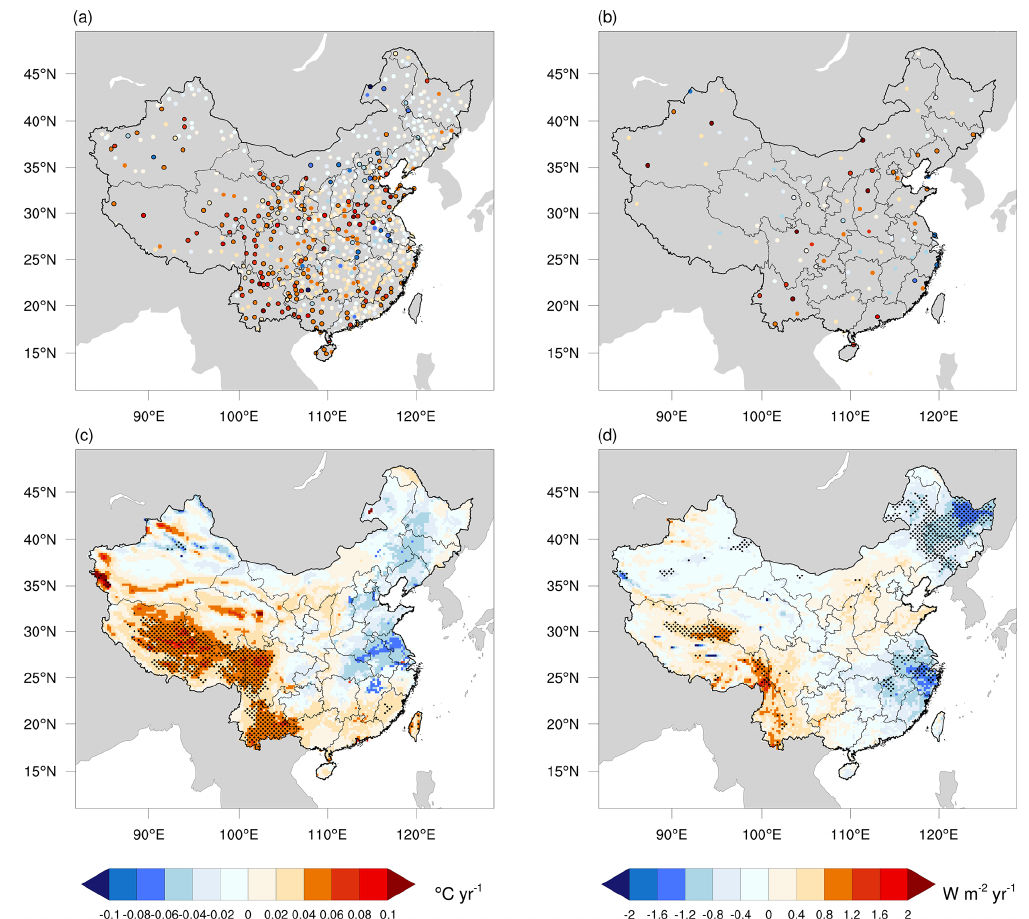
Figure 3. The trend of growing-season-averaged 2m temperature ( T 2) and downward shortwave radiation (DSW). Panels (a) and (b) are for in situ T 2 and DSW, respectively, and the sites with a statistically significant trend are marked by black circles. Panels (c) and (d) are for the WRF-simulated T 2 and DSW, respectively, and the regions with statistically significant trends are illustrated by shadow.